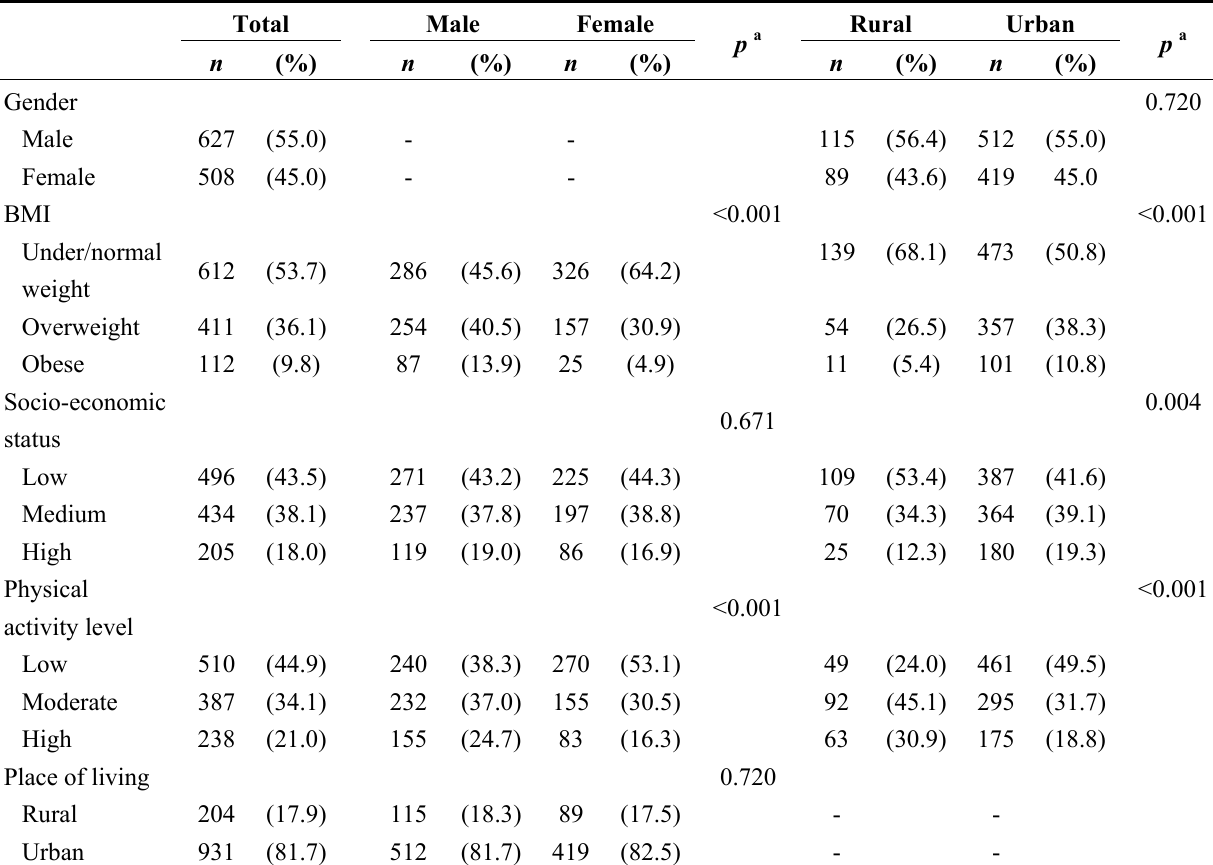
Table 1. Socio-demographic and lifestyle characteristics of the 1135 participants, by gender and place of